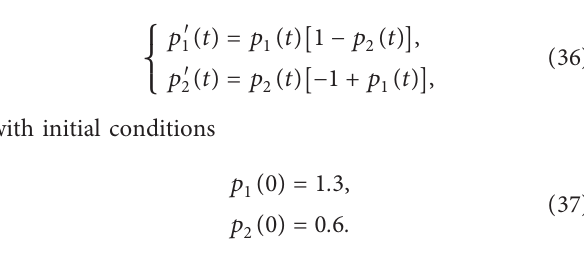
Table 2: Comparison of the absolute errors obtained by different rates for R